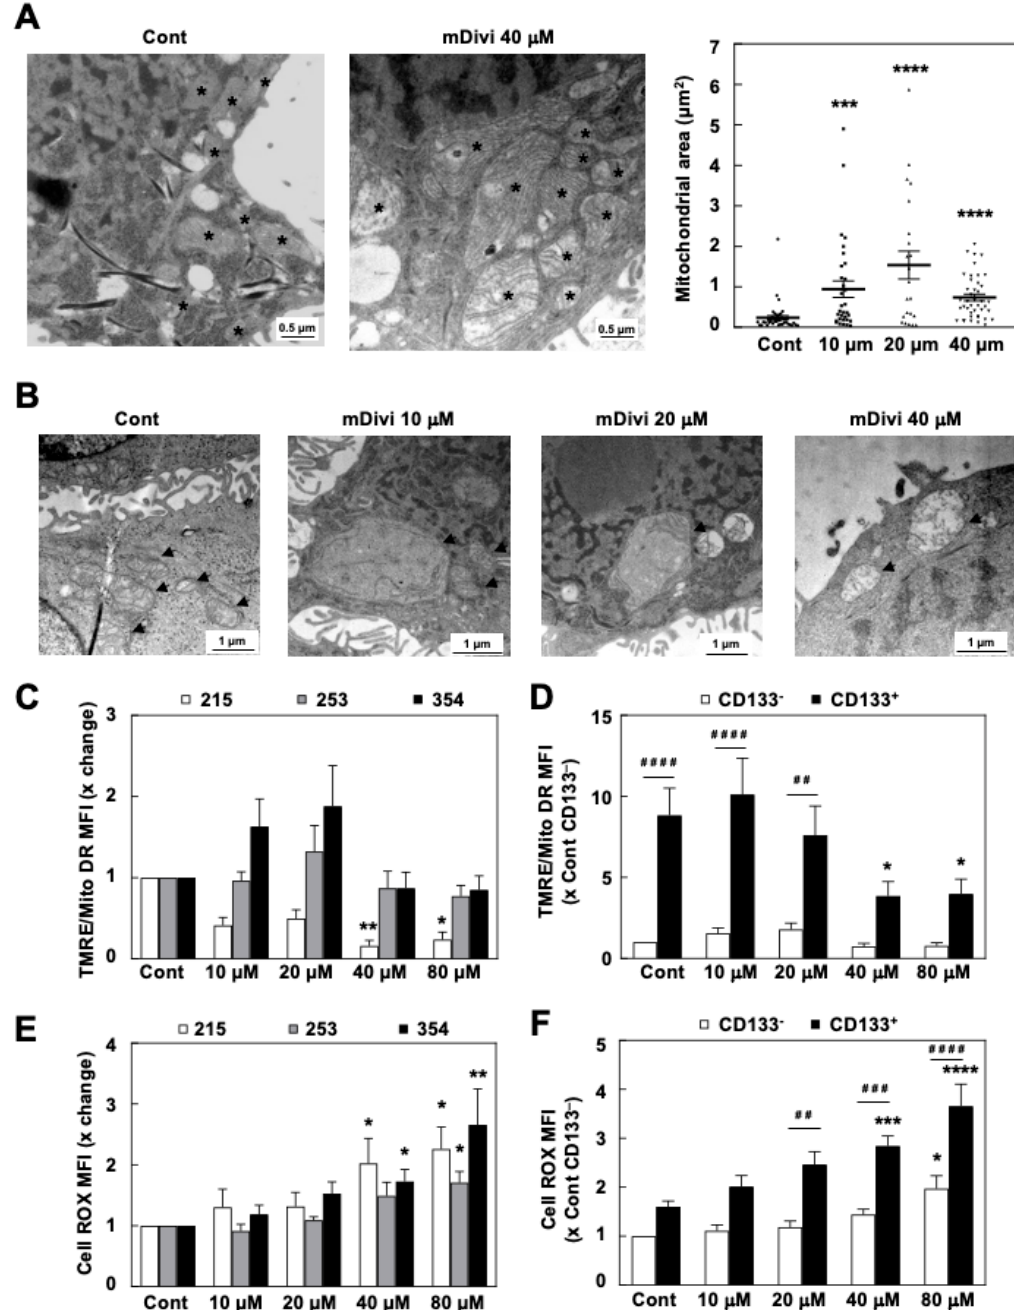
Figure 3. mDivi-1 treatment induces the accumulation of dysfunctional mitochondria. ( A ) TEM pictures (40,000×, left) and quantification of the mitochondrial area (right) for 354 cells with or without treatment with 40 µM mDivi-1 for 48 h ( n = 33–43 mitochondria). *** p < 0.001, **** p < 0.0001; Kruskal–Wallis with Dunn’s post-test. ( B ) Selected areas of mDivi-1 treated cells as shown in ( A ), demonstrating altered mitochondrial morphology. ( C , D ) Ratio of mitochondrial activity as assessed by TMRE on mitochondrial mass (Mito DR) for bulk cancer cells ( C ) or for CD133 – vs. CD133 + cells. Pooled data for 215, 253, and 354 PDAC cells ( D ) ( n = 4–9). ( E , F ) Reactive Oxygen Species (ROS) production as assessed by DCFDA for the bulk population of the indicated PDAC cells ( E ) or for CD133 − vs. CD133 + cells. Pooled data for 215, 253, and 354 cells ( F ) ( n = 4–7). * vs. control, * p < 0.05, ** p < 0.01, *** p < 0.001, **** p < 0.0001. # vs. CD133 − , ## p < 0.01, ### p < 0.001, #### p < 0.0001. Kruskal–Wallis with Dunn’s post-test ( C , E ); ANOVA with Bonferroni post-test ( D , F ). Data shown in the figure represent averages ± S.E.M. Flow cytometry data shown represent Mean Fluorescence Intensity (MFI). Controls set as 1 for fold changes.